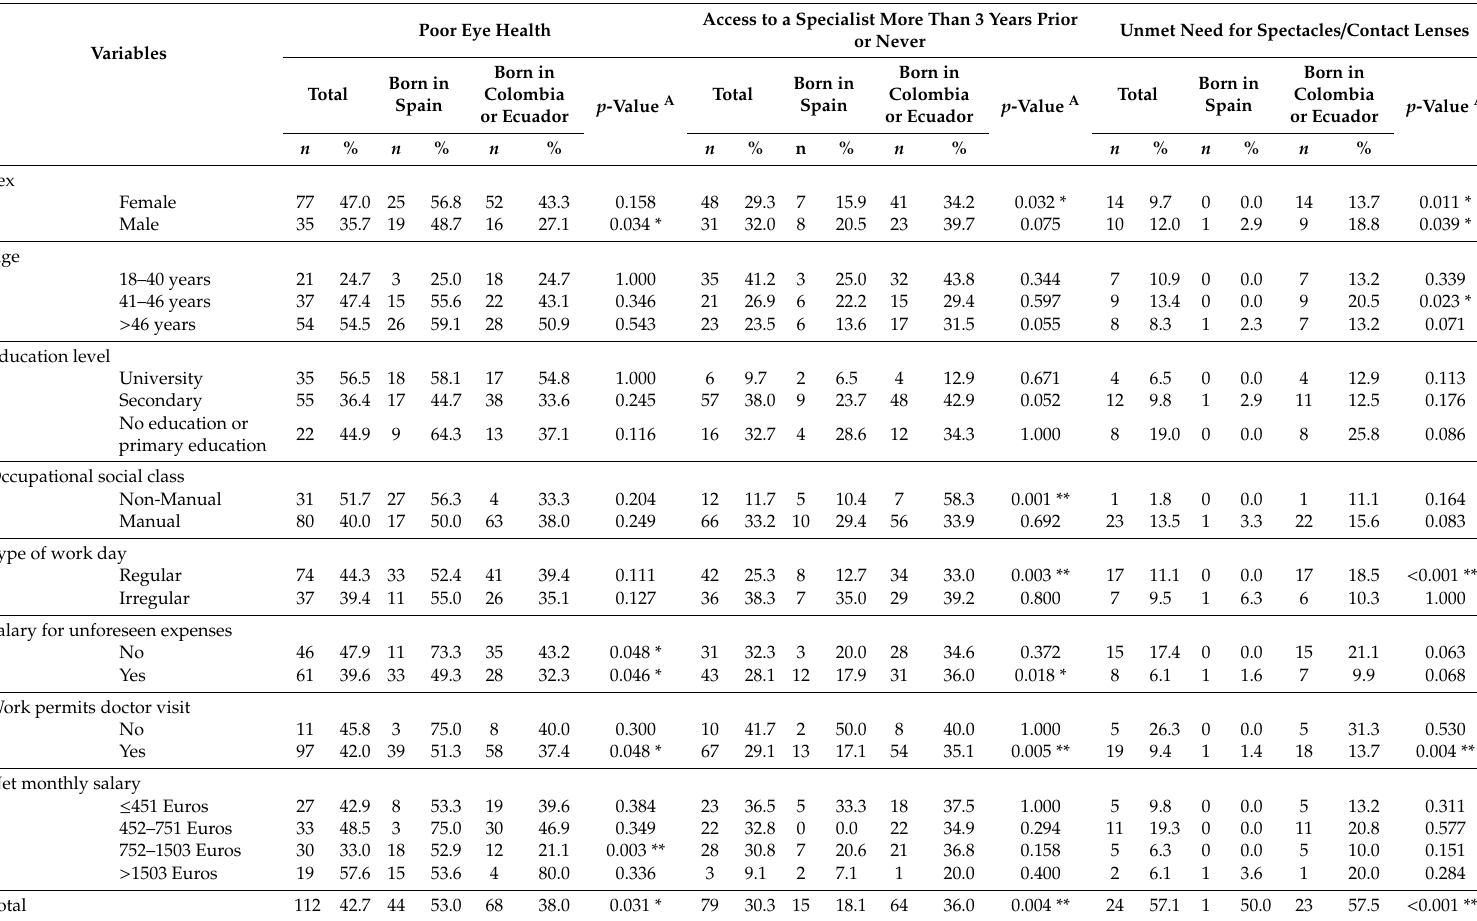
Table 3. Prevalence of poor self-perceived eye health, access to an eye care specialist (ophthalmologist / optician–optometrist) more than three years prior or never, and unmet need for lenses in workers included in the study by sociodemographic and occupational variables and country of